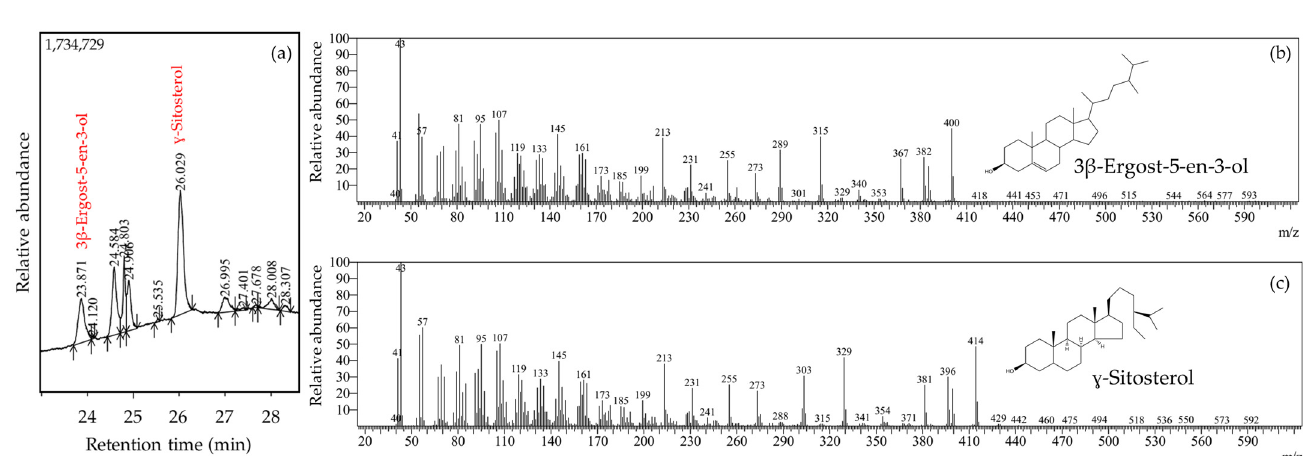
Figure 1. GC chromatogram of ethanolic extract from L. acidissima fruits at the retention time range of 23–29 min ( a ). Mass spectra of predominating compounds namely 3 β -ergost-5-en-3-ol ( b ) and ɣ -sitosterol ( c ) after their separation from the ethanolic extract from L. acidissima fruits via GC.